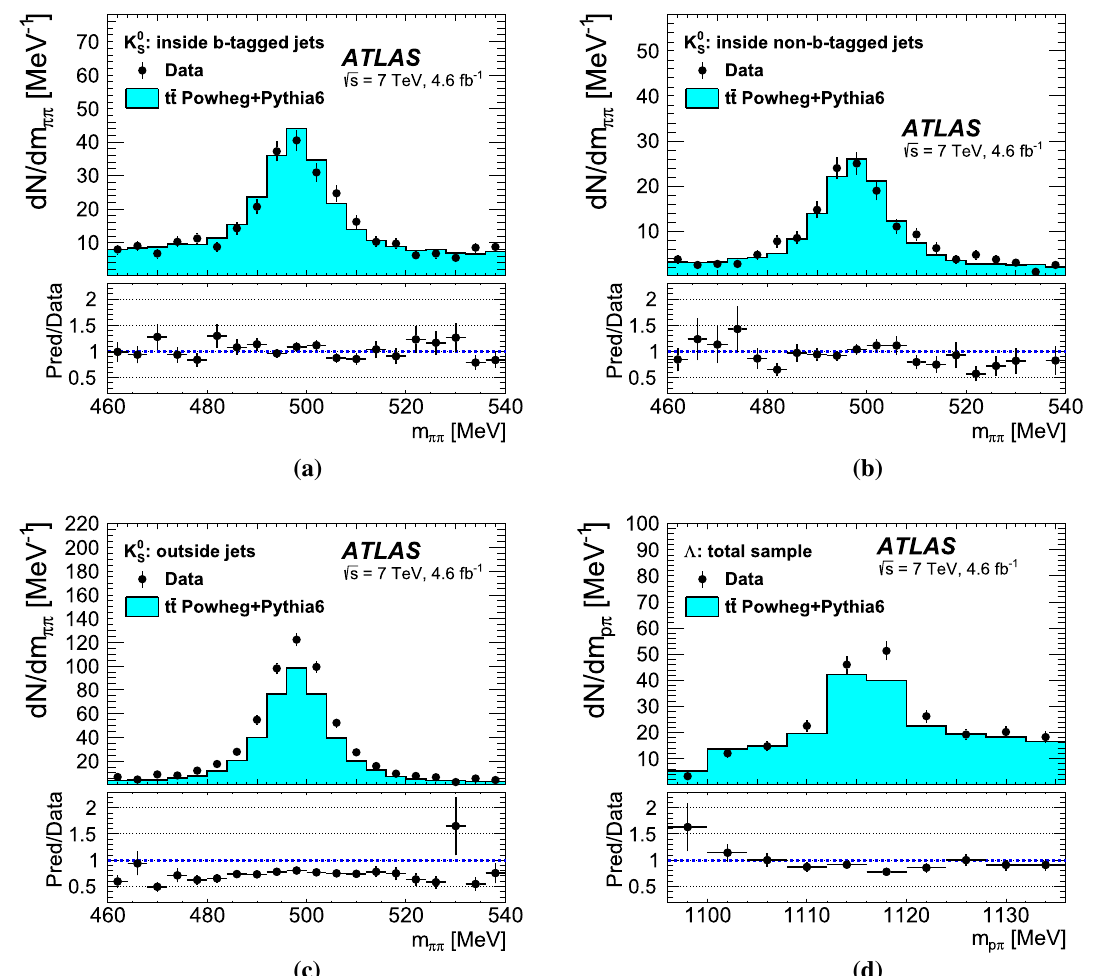
Fig. 2 K 0 and (cid:3) candidate mass distributions in data compared with Powheg + Pythia6 simulation. Three classes are presented for K 0 S b -tagged jets, b inside non- b -tagged jets, and c outside any jet. The total sample is shown for d (cid:3) candidates